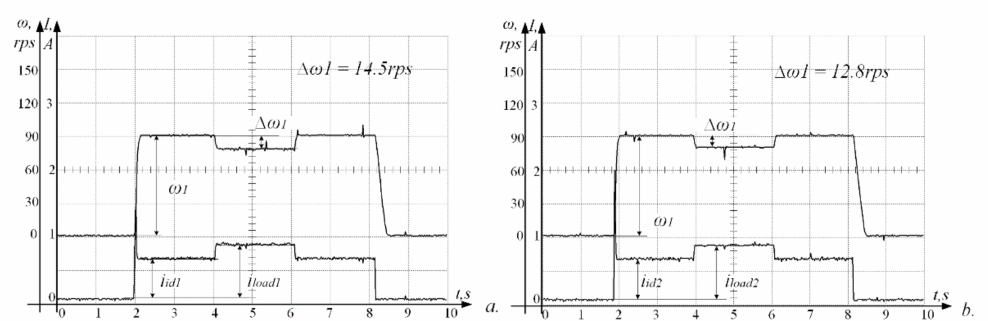
Figure 3. Diagrams of processes in asynchronous drive with scalar ( a ) and vector sensorless ( b )